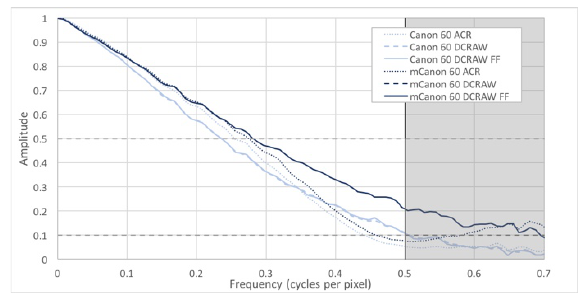
Figure 8. Horizontal SFR curve measured from the slanted edge features at the middle of the DICE target using the unmodified and modified cameras with the Coastal Optics 60 mm lens. The 10% and 50% SFR ranges are marked by dotted horizontal lines and the Nyquist frequency is marked by a vertical black line at 0.5 cycles per pixel. The grey region indicates frequencies that are at risk of aliasing.